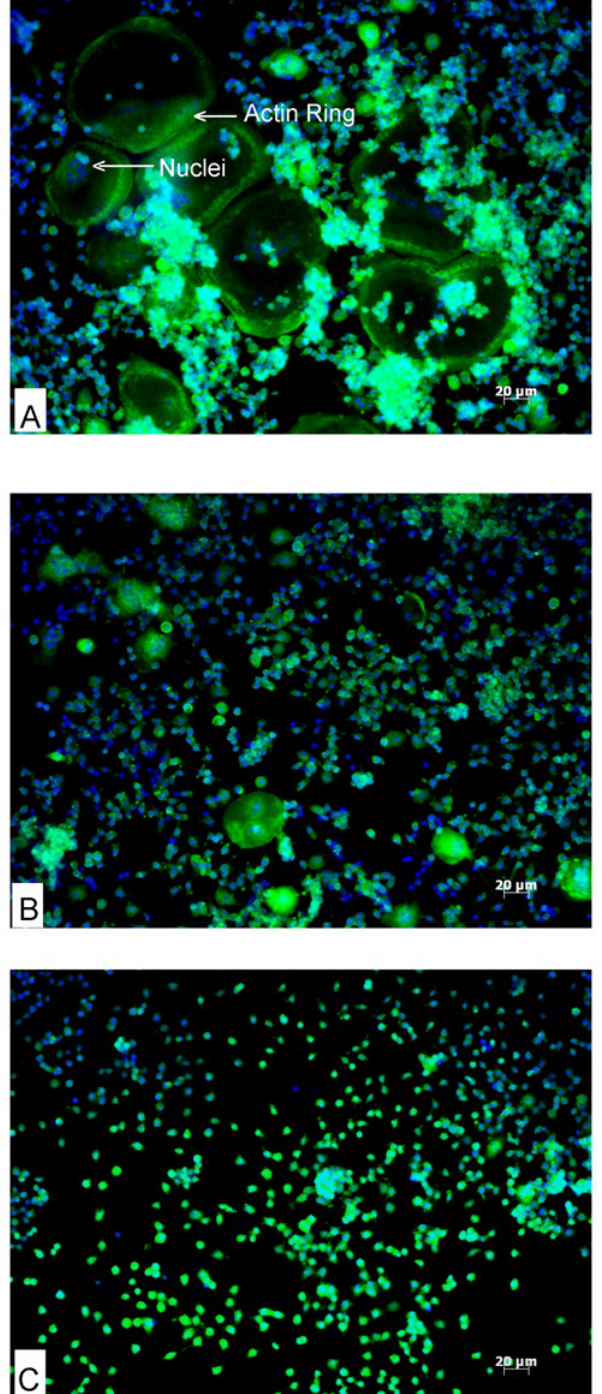
Figure 2. Effects of AA and DHA on RANKL-induced actin ring formation. RAW264.7 cells were differentiated into osteoclasts in the presence of 30 ng·mL −1 RANKL alone ( A ) or co-stimulated with AA ( B ), or DHA ( C ) at 20 μg·mL −1 . Phalloidin (green fluorescence) stains the actin filaments, and Hoechst 33342 (blue) stains the nuclei of cells. Mature differentiated osteoclasts appear as large green cells with multiple nuclei and a green (actin) ring. Experiments were repeated three times in duplicate; one representative field of view is shown for each